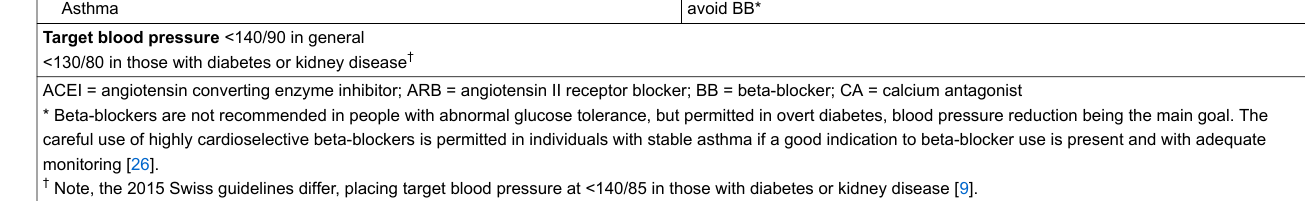
Comorbidity specific treatement, recommended drugs Coronary heart disease Heart failure Diabetes Dyslipidaemia Migraines